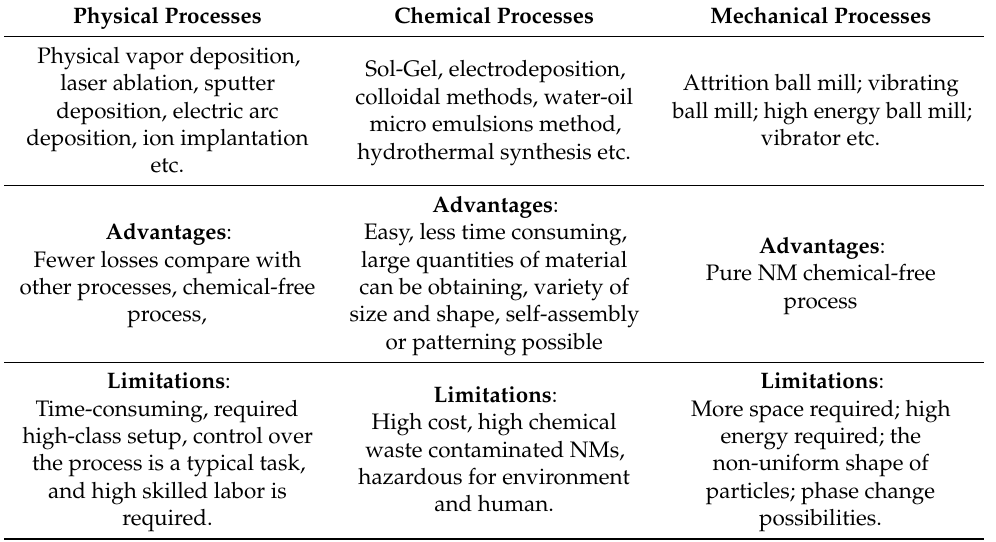
Table 6. Comparison of different nanomaterials synthesis process mechanism